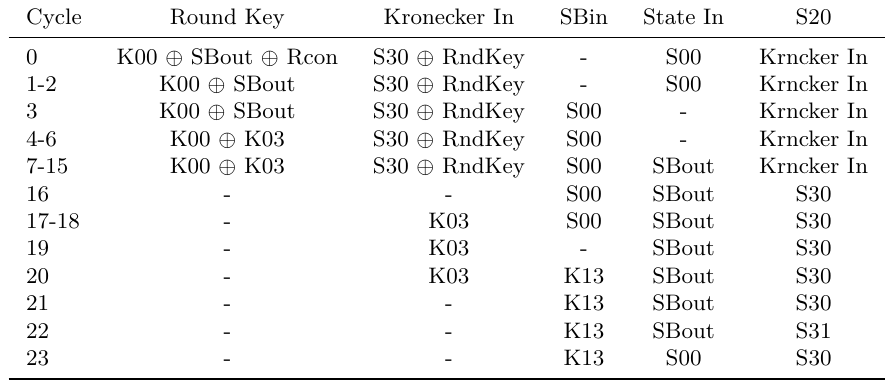
Table 2: State and key inputs during one round of encryption (except during loading) Cycle Round Key